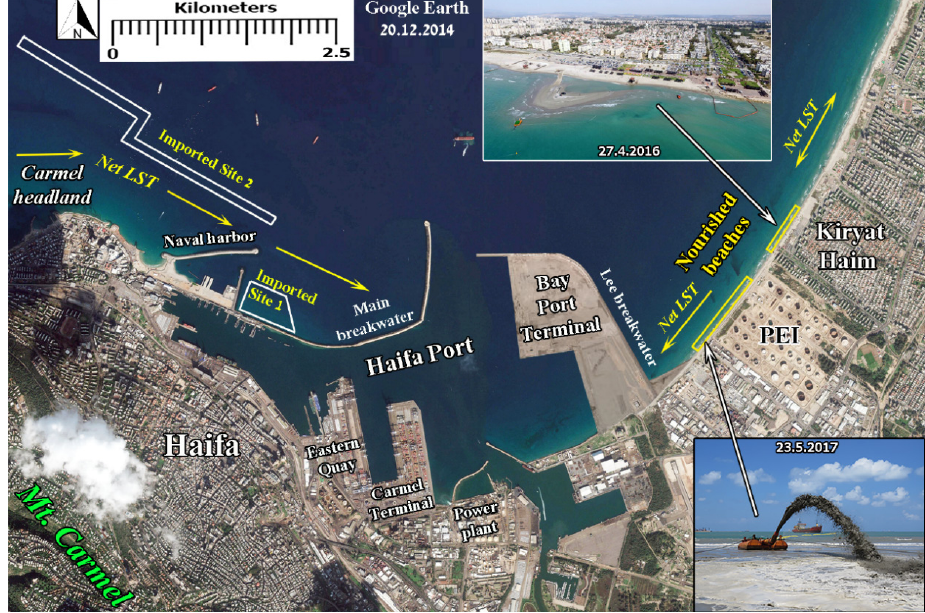
Figure 6. South Haifa Bay sand beach nourishment projects (May 2016–June 2017). Aerial photograph of Kiryat Haim bathing beach (Yehudit Naot Beach) during the first nourishment operation ( top inset). Nourishment rainbowing operation via discharge pipe south of Petroleum and Energy Infrastructure Ltd. (PEI) (23 May 2017) ( bottom inset). Background: Google Earth image, 20 December